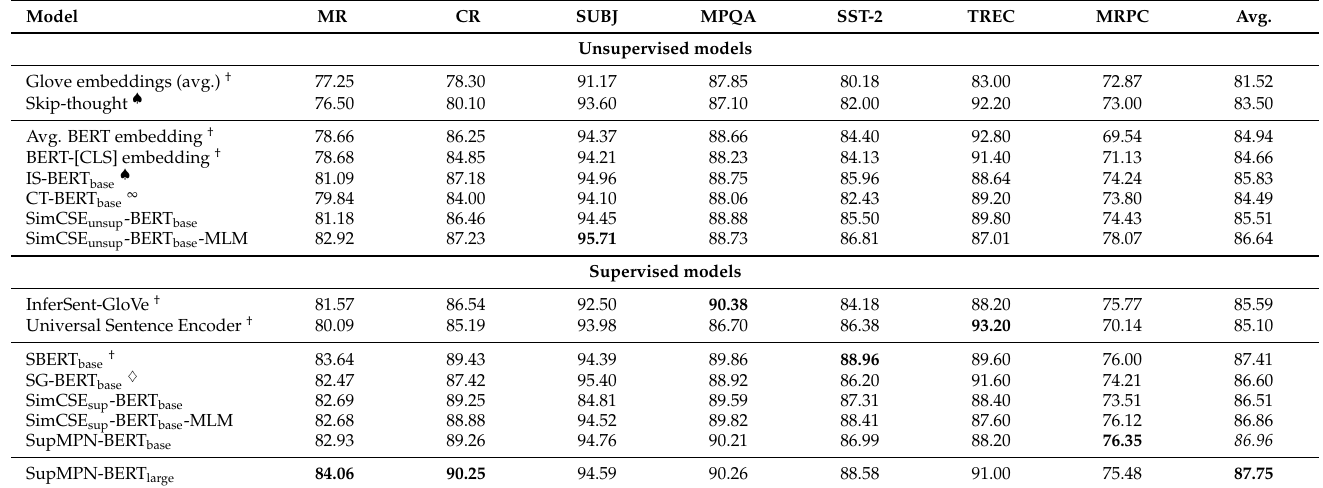
Table 3. Experimental results on the transfer-learning tasks. We report prediction accuracy. The